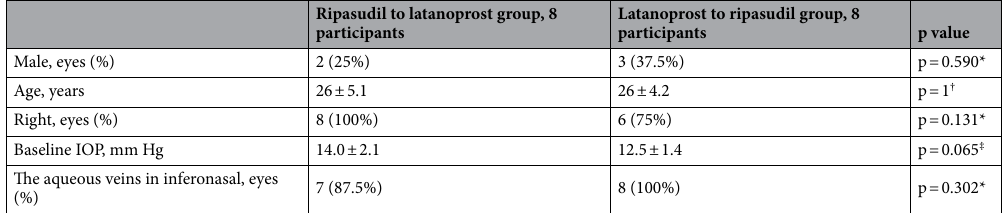
Table 1. Baseline characteristics. Age and IOP; intraocular pressure are mean ± SD. * χ 2 test. † Unpaired t-test. ‡ Wilcoxon rank sum test.